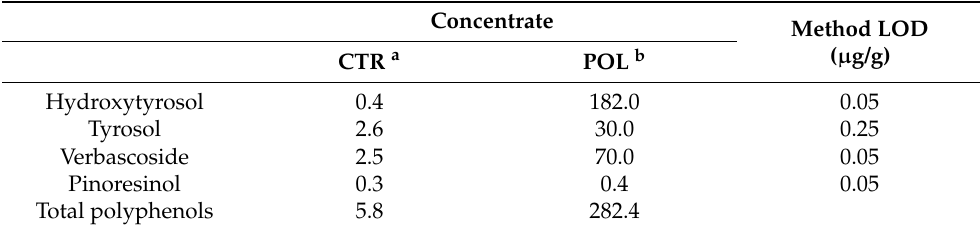
Table 1. Total content of polyphenols ( µ g/g) of the two experimental concentrates used during the